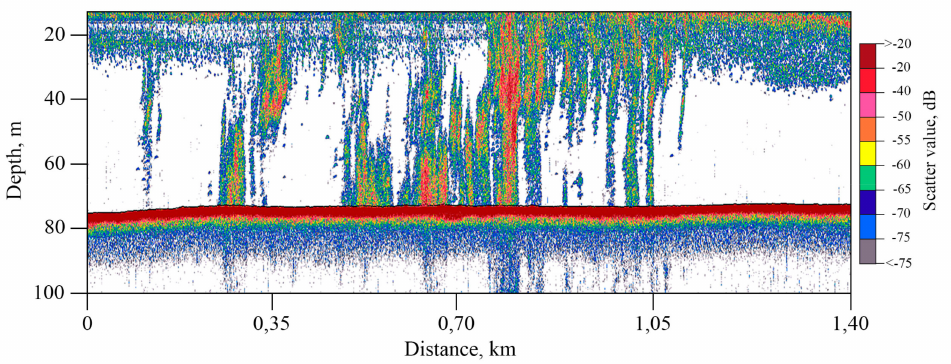
Figure 12. Fragment of a profile with a recording of the high-frequency Simrad EK15 single-beam echo sounder obtained in the Laptev Sea.